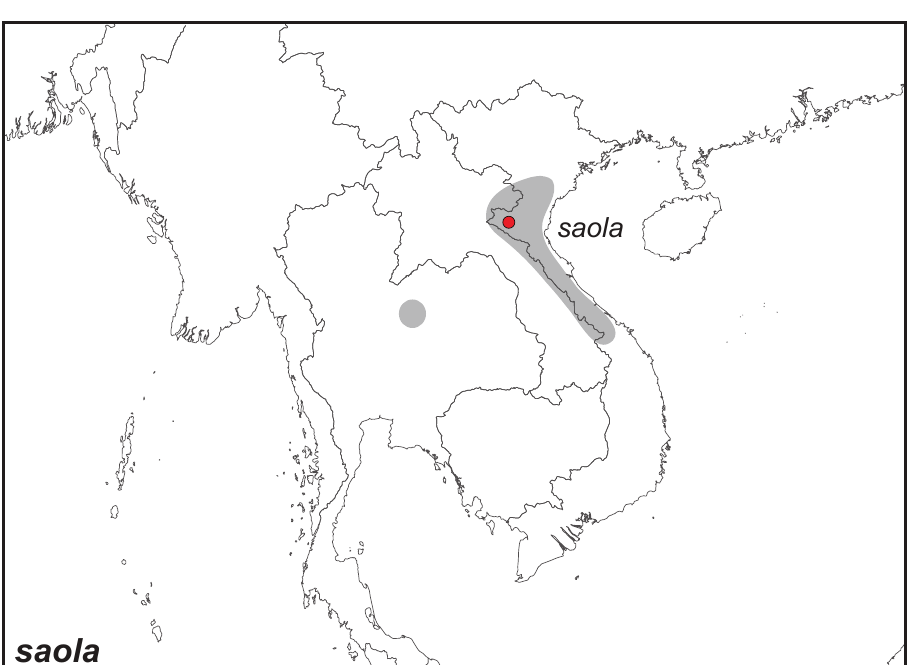
Figure 59. Distribution map of Elymnias kanekoi .